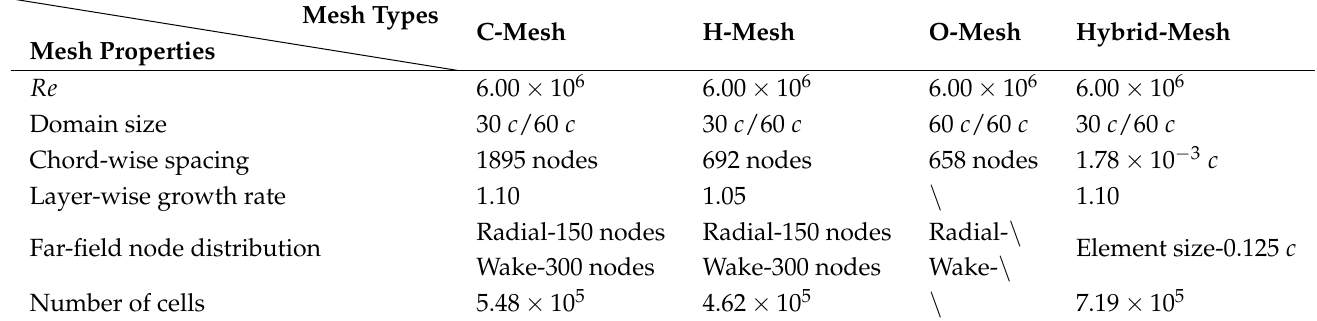
Table 27. Recommended mesh properties for different mesh types.